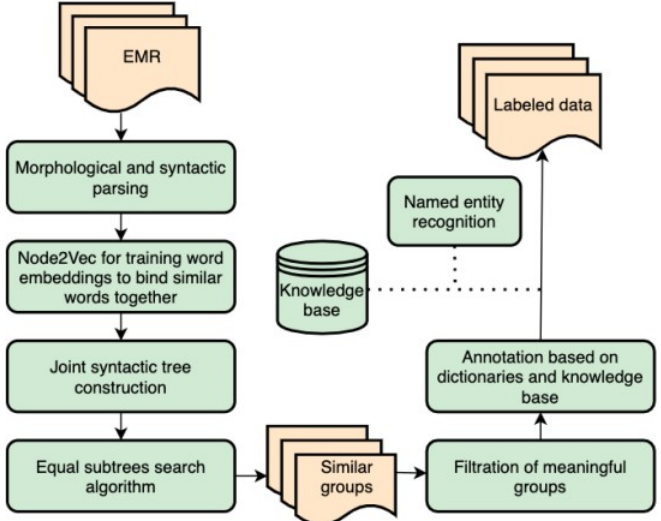
Figure 1. Method schema of sequential modules with EMR as input and labeled groups as output.